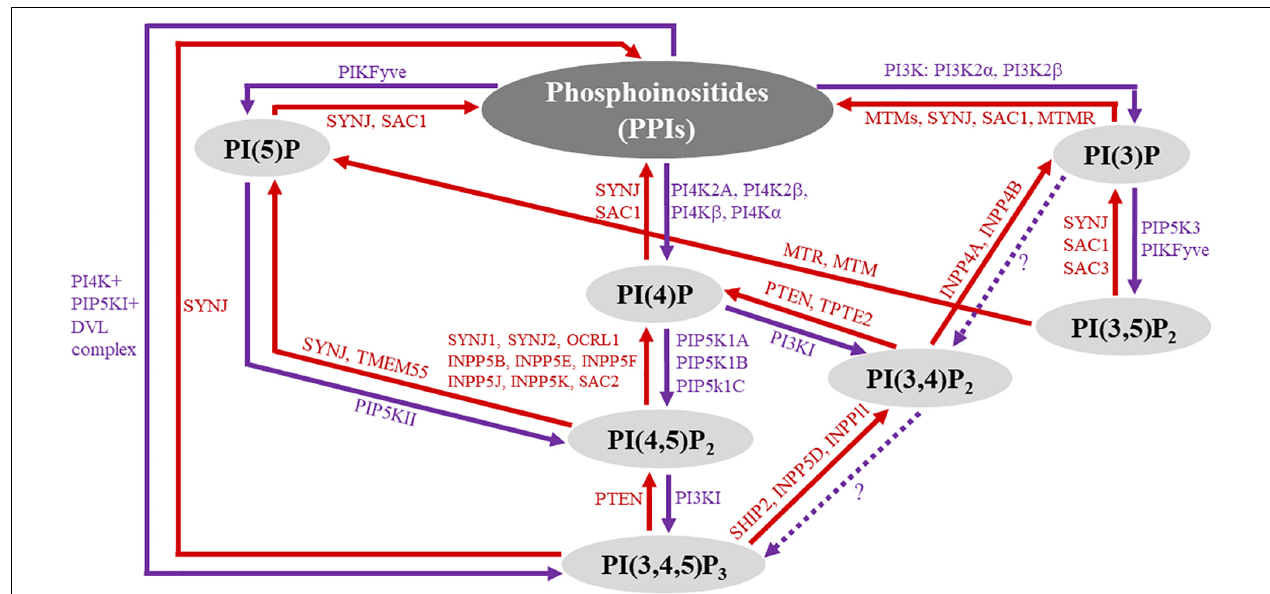
FIGURE 1 | Overview of phosphoinositide (PPI) signaling. The diagram represents an overview of PPI subspecies and their biochemical interconversion. The seven biologically active PPI subspecies are highlighted in gray circles. PPI phosphatases are labeled red, and their associated reactions are represented by red arrows, indicating the direction of the reaction. Similarly, kinase reactions are represented by purple arrows with kinase enzymes labeled purple. Question marks along the dotted arrows represent areas that have yet to be